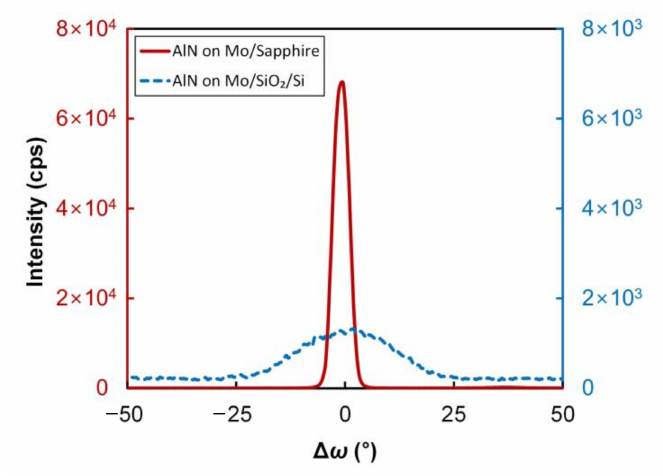
Figure 2. Comparison of the XRD rocking curves of AlN (002) on the Mo/sapphire and Mo/SiO 2 /Si substrates.